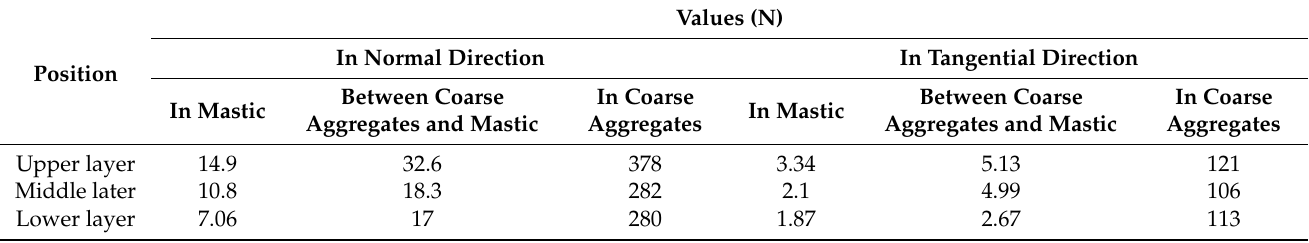
Table 4. Maximum contact force in asphalt surface